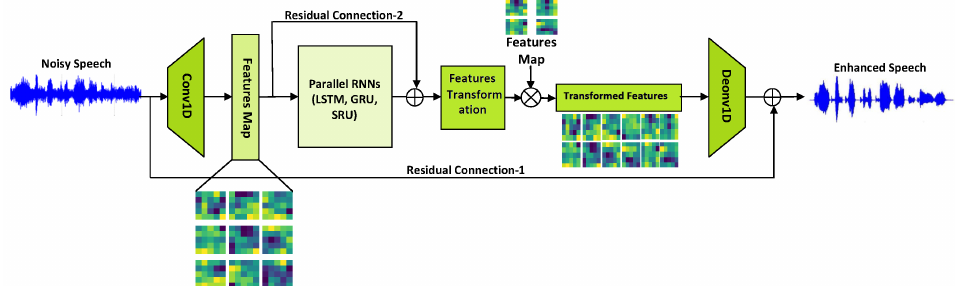
Figure 2. Architecture of the proposed E2E model. It integrates 1D-CNN with bidirectional RNNs: Long Short-Term Memory (LSTM), Gated Recurrent Unit (GRU), Simple Recurrent Unit(SRU). There are two residual connections; (i) adding recurrent net input to recurrent net output and (ii) adding input to the Deconv-1D layer